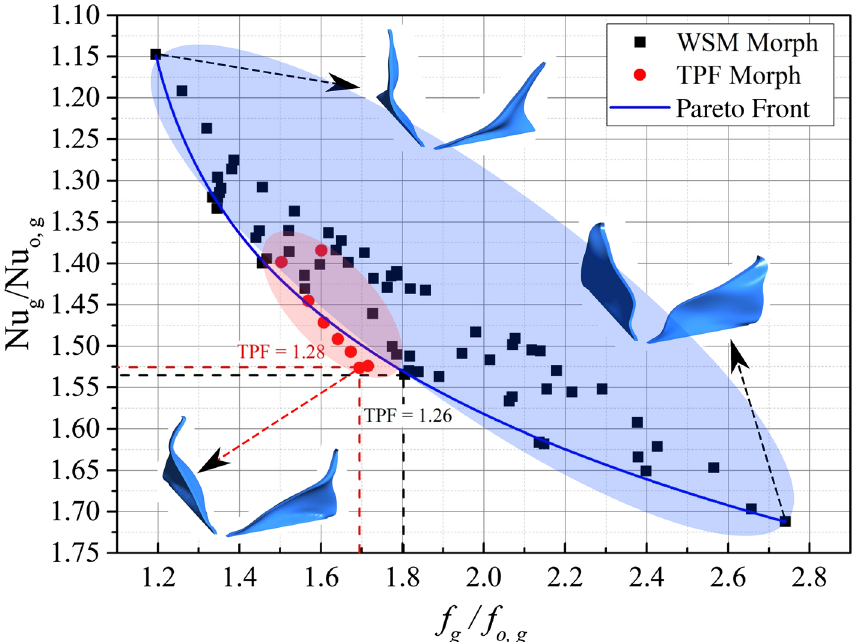
Figure 1. Pareto Front of the optimum designs of RVG using adjoint-based optimization employing two different bi-objective functions: f 1 (TPF Morph based, Eqs. 4, 9); f 2 (WSM Morph based, Eq. 5). The overall computational time to obtain the TPF morph-based optimum design is reduced tenfold compared to the WSM. This reduction in computational time can be explained by the reduction of the design space of the exploration represented schematically by the two coloured zones in red (for f 1 ) and blue (for f 2 ). The optimal RVG design obtained by f 1 has TPF = 1.28 and the optimal RVG design obtained by f 2 has TPF = 1.26